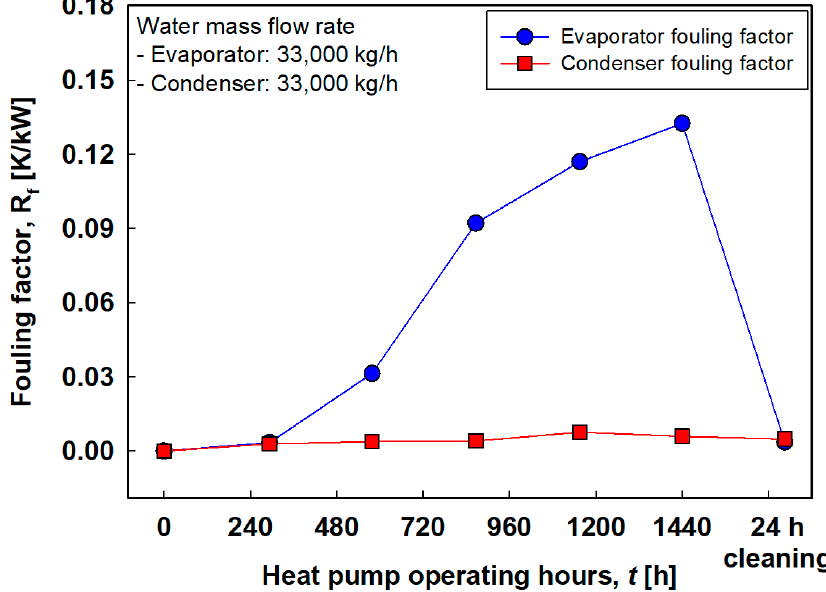
Figure 11. Variation of fouling factor according to heat pump operating hours.